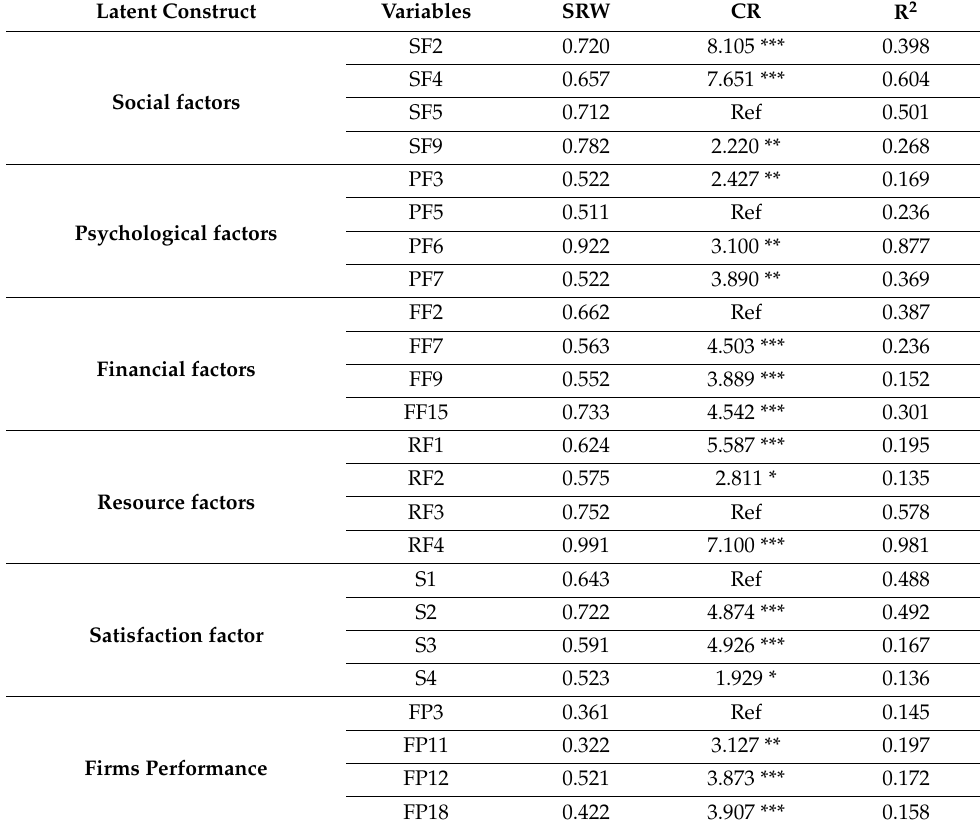
Table 3. Results of confirmatory factor